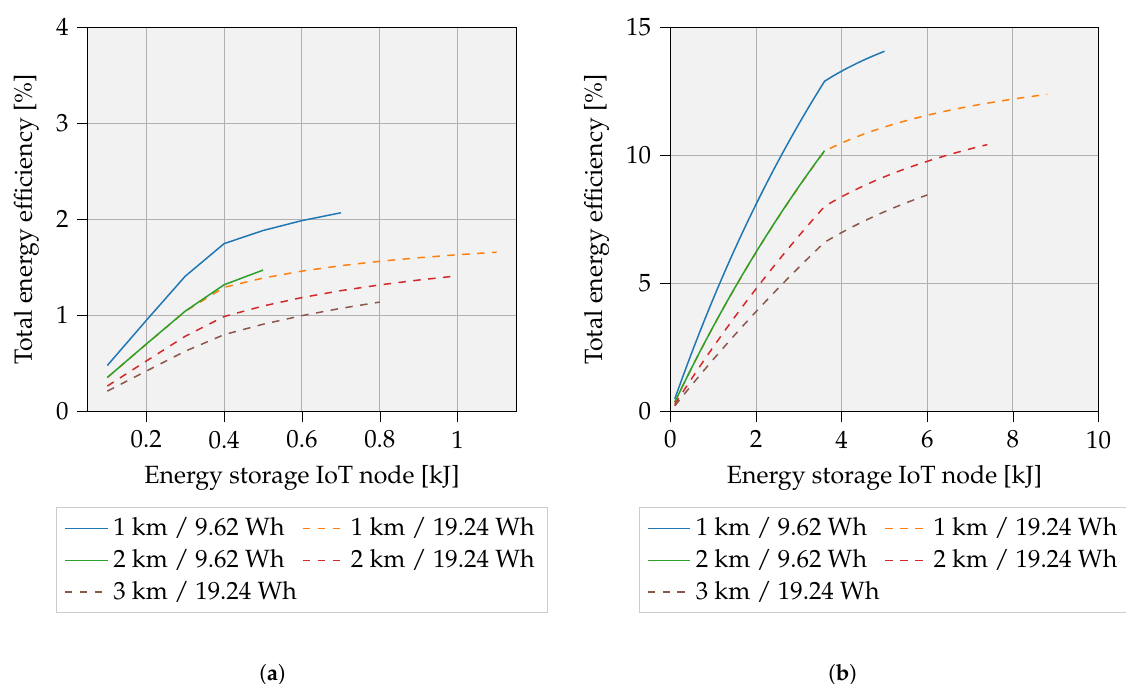
Figure 16. Overall energy efficiency including travel, WPT, and hover losses. A 3km travel distance with a single UAV battery is not achievable, as also noted in previous analyses. ( a ) P ch,max = 1W; ( b ) P ch,max =